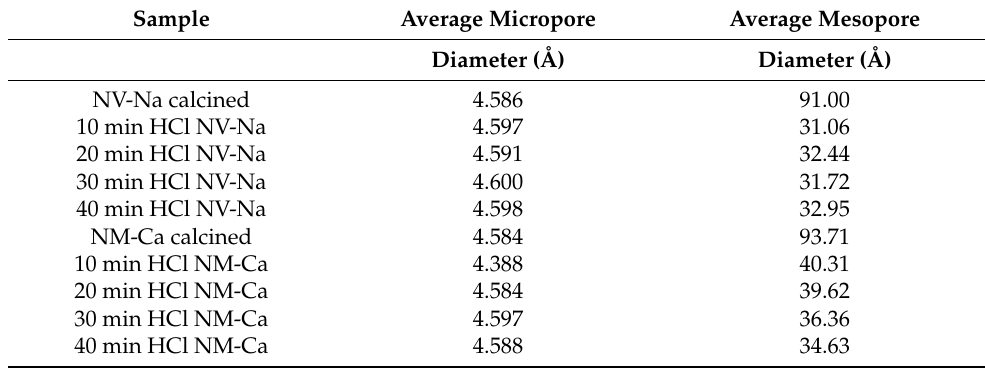
Table 2. The average mesopore and micropore